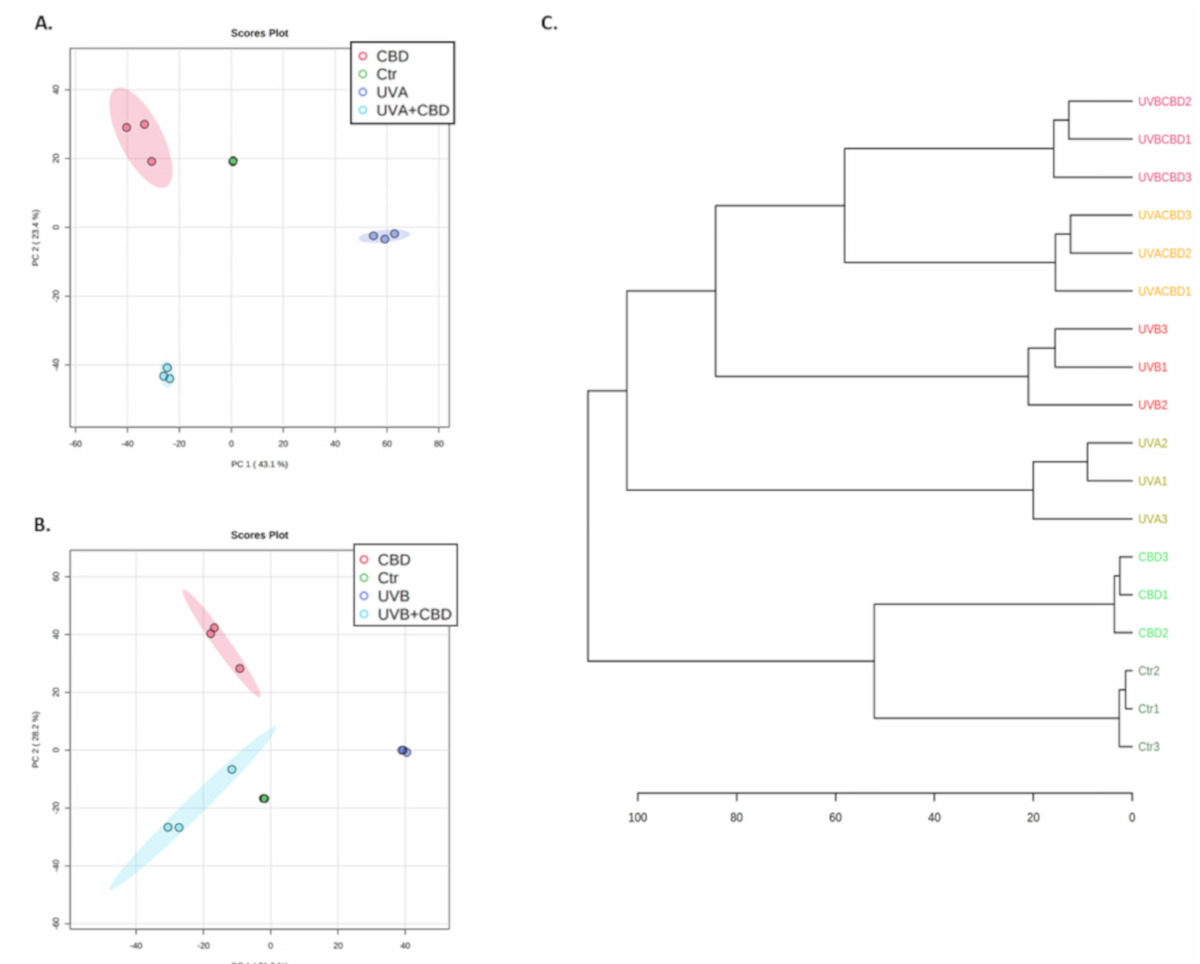
Figure 3. Principal component analysis (PCA) of keratinocytes cultured in a three-dimensional culture model and treated with cannabidiol (4 µ M) following UVA (30 J/cm 2 ) ( A ) or UVB (60 mJ/cm 2 ) ( B ) radiation, as well as a hierarchical dendrogram ( C ) of these samples. Abbreviations: Ctr, control; CBD, cannabidiol; PC, principal